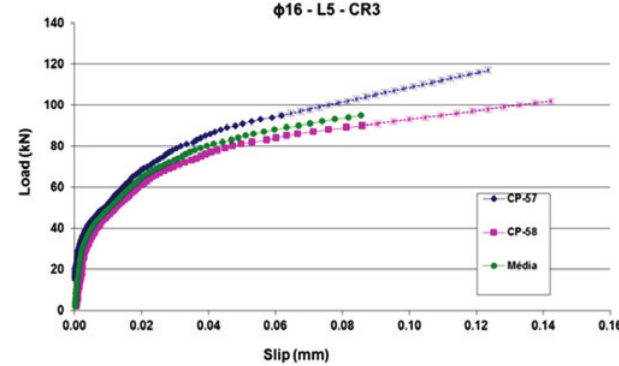
Load- slip, models CR 12.5-7.5-2 Load- slip, models CR 16-5-3